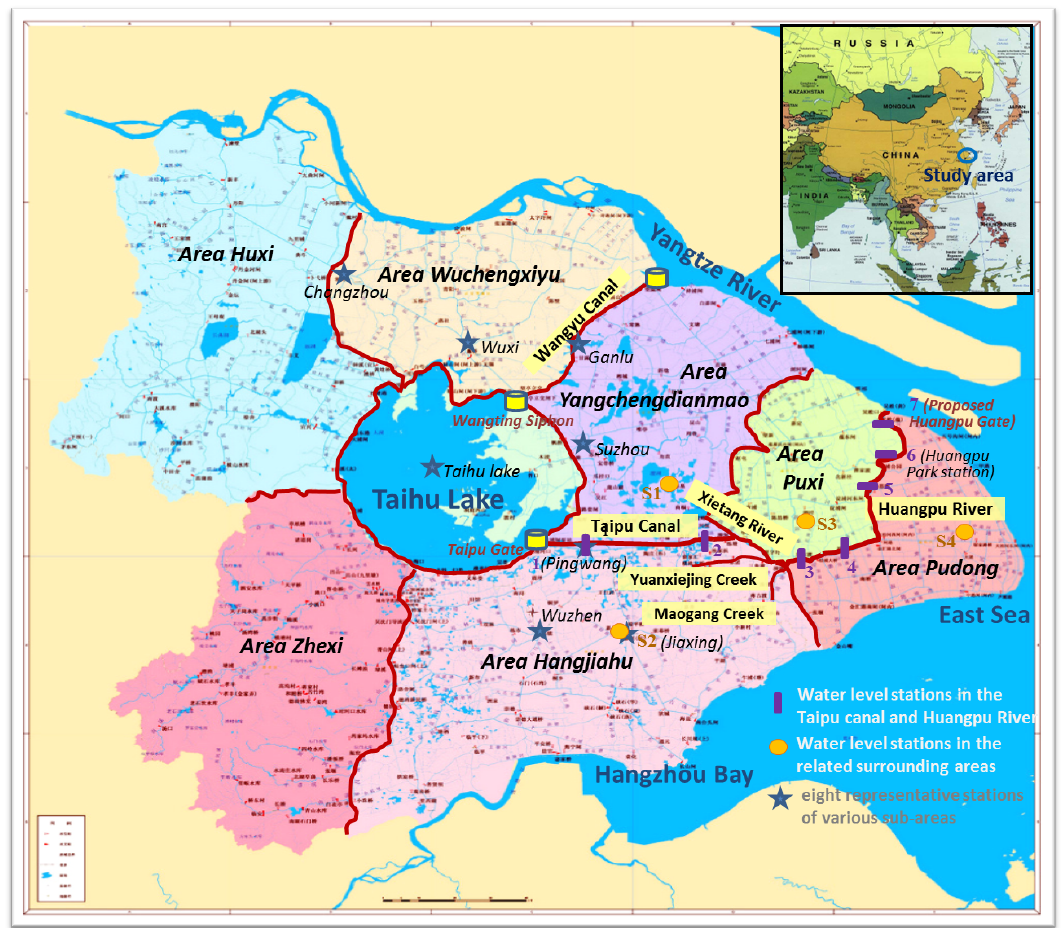
Figure 1. Location map of the Lake Taihu basin in eastern